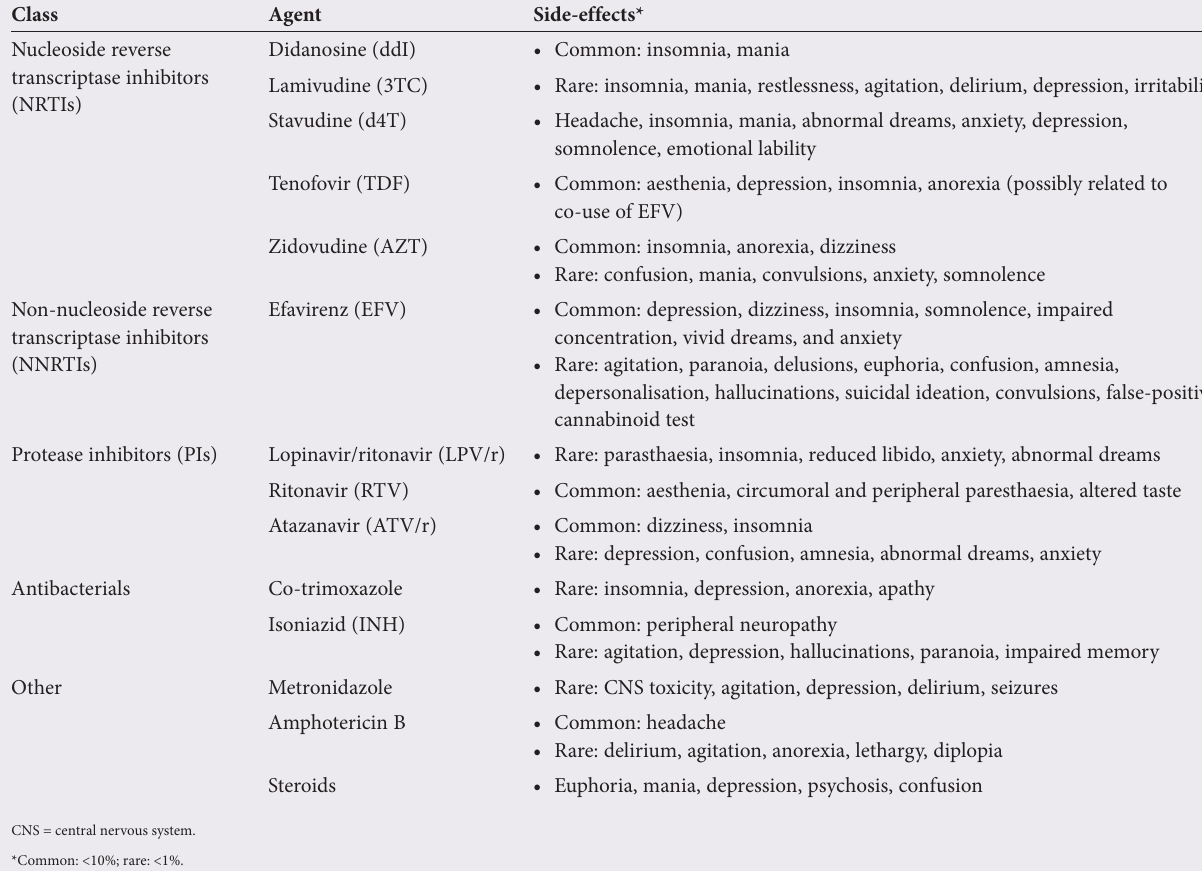
Table 1. ARV side-effects Class